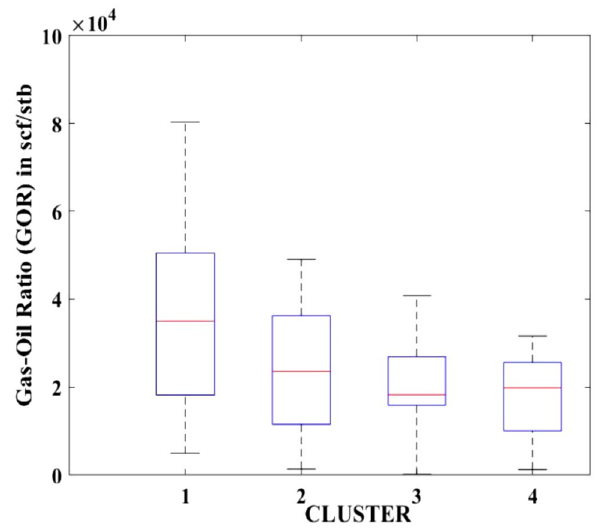
Figure 14. Initial 24-h period GOR.